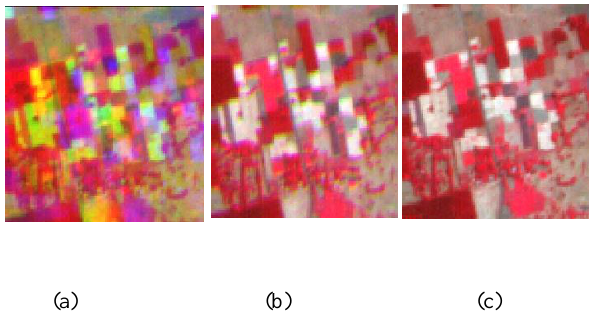
Figure 14. Band to band registration (a) original image (b) corrected with given attitude information (c) corrected with residual attitude computed over and above the given attitude